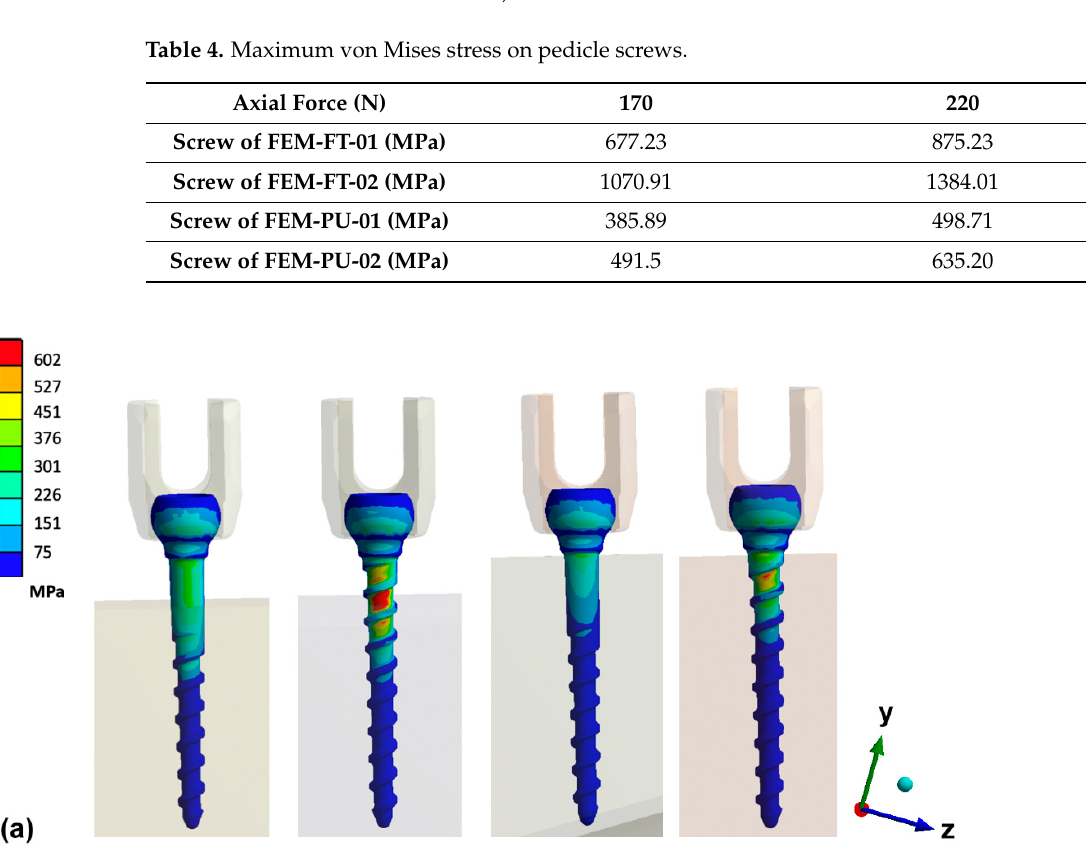
Figure 4. The distribution of the maximum von Mises stress on ( a ) pedicle screws of four models and ( b ) rods of the FEM-FT-01 model under 170 N axial loading.